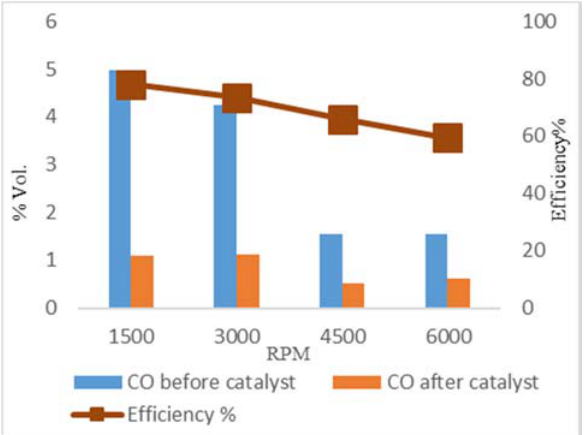
Figure 8. Conversion of CO with Co 3 O 4 /TiO 2 .